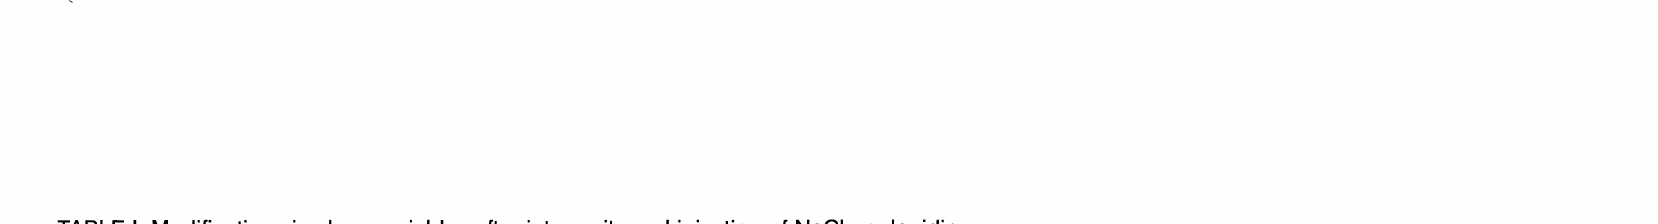
TABLE I. Modifications in sleep variables after intraperitoneal injection of NaGI or clonidine Variables (min)